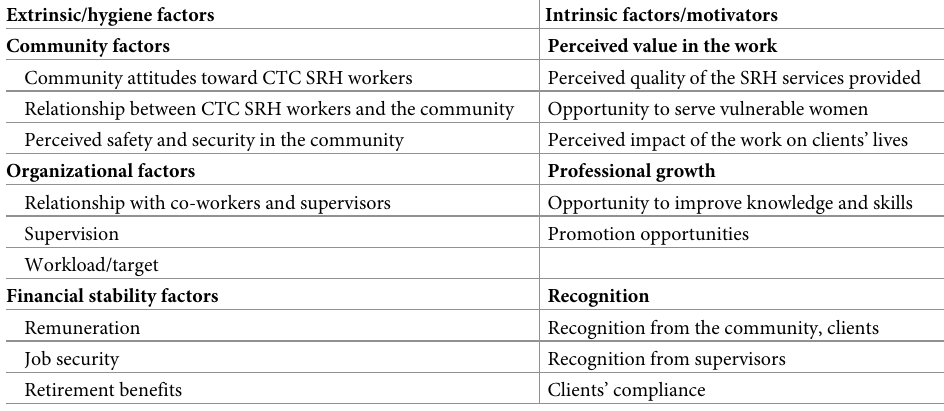
Table 2. Empirical constructs of motivation in CTC SRH workers in low-income urban settlements in Bangladesh. Extrinsic/hygiene